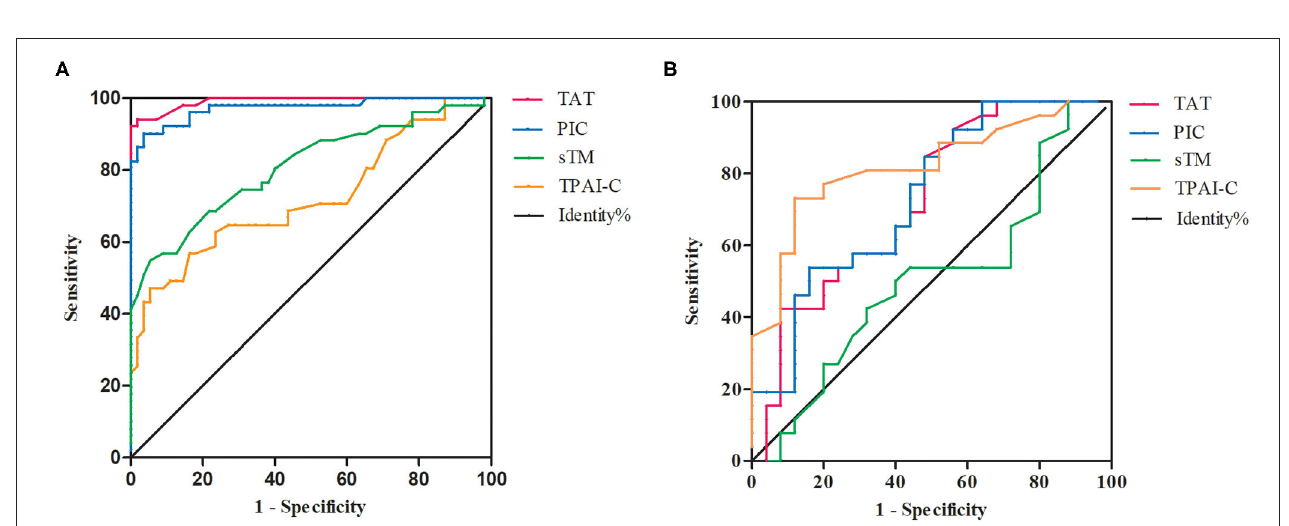
FIGURE 3 | The receiver operating characteristic (ROC) curves of thrombin-antithrombin complex, plasmin alpha2-plasmin inhibitor complex, soluble thrombomodulin, and tissue plasminogen activator-inhibitor complex. (A) The ROC curves for the diagnosis of ovarian hyperstimulation syndrome (OHSS). (B) The ROC curves for the differential diagnosis of mild–moderate and severe OHSS. TAT, thrombin-antithrombin complex; PIC, plasmin alpha2-plasmin inhibitor complex; sTM, soluble thrombomodulin; TPAI-C, tissue plasminogen activator-inhibitor